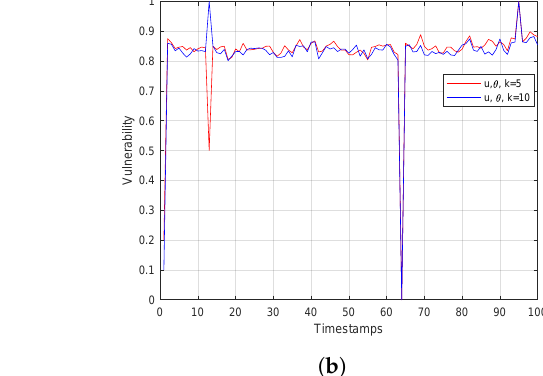
Figure 9. ( a ) Euclidean Space and ( b ) Polar Space for N = 500 Trajectories, L = 100